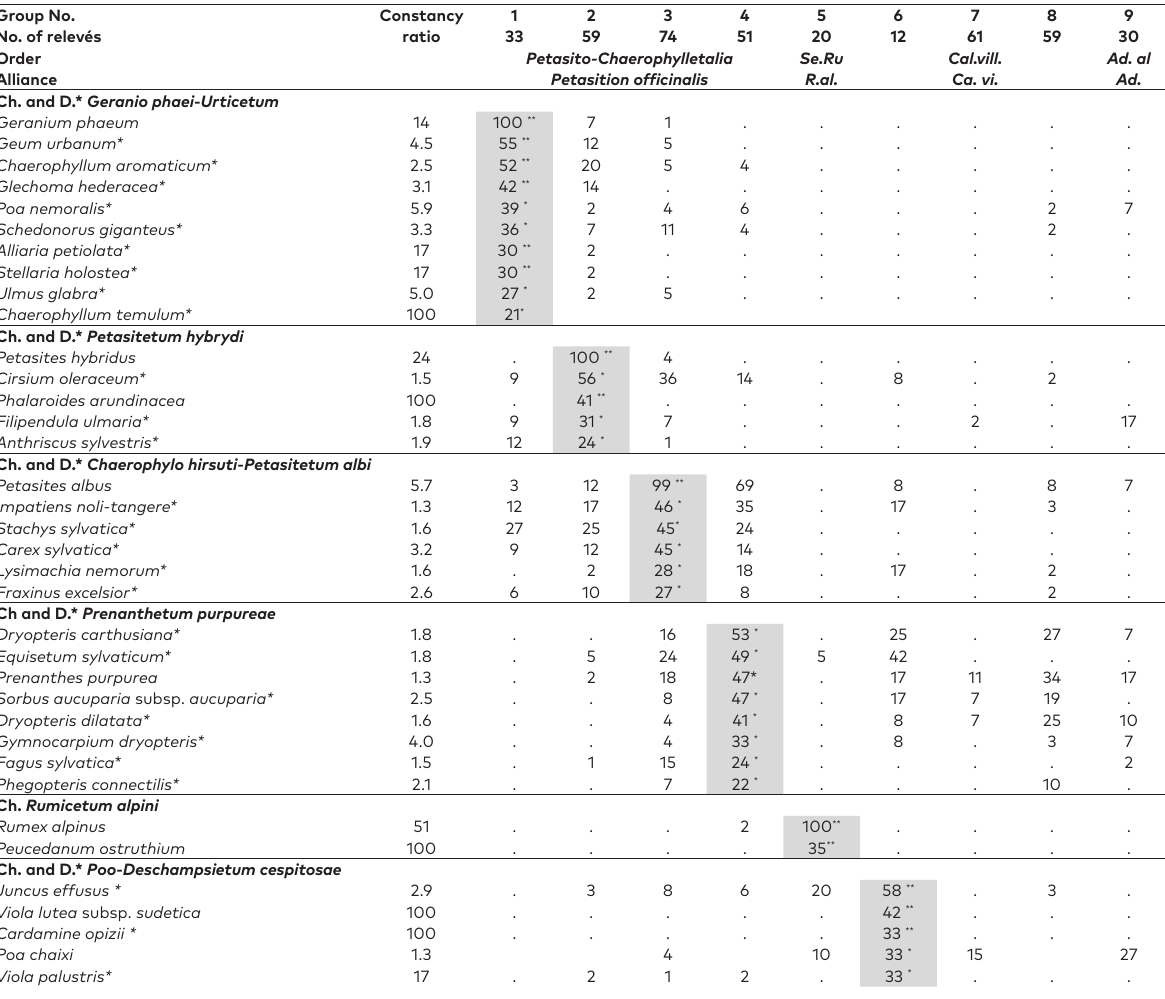
Table 1. Summarized synoptic table with percentage frequency and fidelity values derived from 399 relevés of tall-herb associations of the Mulgedio-Aconitetea in the Sudetes Mts. and their foothills (SW Poland). The positive Φ coefficient values (multiplied by 100) are presented as superscripts (*: 25 to 49, **: ≥ 50). Species diagnostic for both one or several clusters ( Φ ≥ 25 and constancy ratio ≥1.3) are shaded in grey. Character and differentiating species were sorted according to constancy, while the other species were sorted according to the number of occurrences in clusters or resemblance to the diagnostic species in neighboring cluster. Among accompanying species, only the most common ones, which occurred in at least seven clusters, were included in the table. Abbreviations: Ch: character species; D*: regionally differentiating species (marked in the table with asterisk). Shortened names of syntaxa: Se.Ru .: order Senecioni rupestris-Rumicetalia alpini ; Cal.vill. : order Calamagrostietalia villosae ; Ad.al. : order Adenostyletalia alliariae ; R.al.: alliance Rumicion alpini ; Ca.vi .: alliance Calamagrostion villosae ; Ad .: alliance Adenostylion alliariae. Group